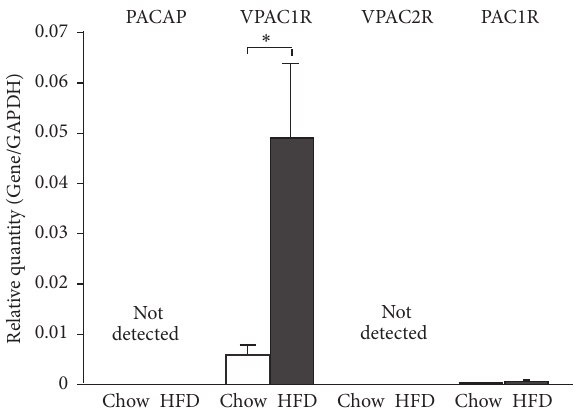
Figure 6: Expressions of PACAP and PACAR receptor subclasses in liver. The mRNA expressions of PACAP and PACAR receptors, VPAC1-R, VPAC2-R, and PAC1-R, in the liver of ICR mice fed regular chow and HFD for 6 weeks. 𝑛 = 5-6 for each group. Each bar represents mean ± s.e.m. ∗ 𝑝 < 0.05